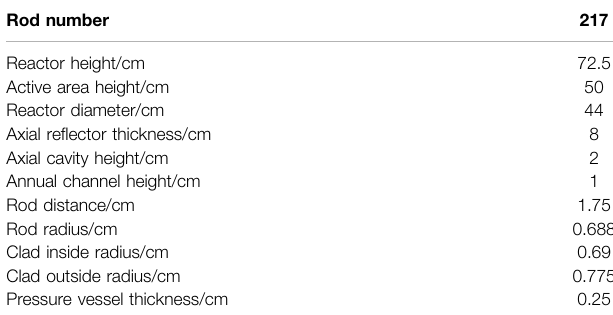
TABLE 1 | Preliminary reactor design